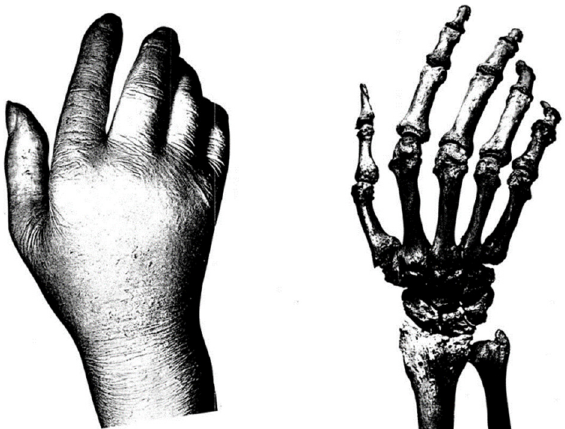
Figure 2. Waldeyer’s right hand ( left ) and the skeleton of the right hand ( right ) according to Hans Virchow’s description (1923) [4].